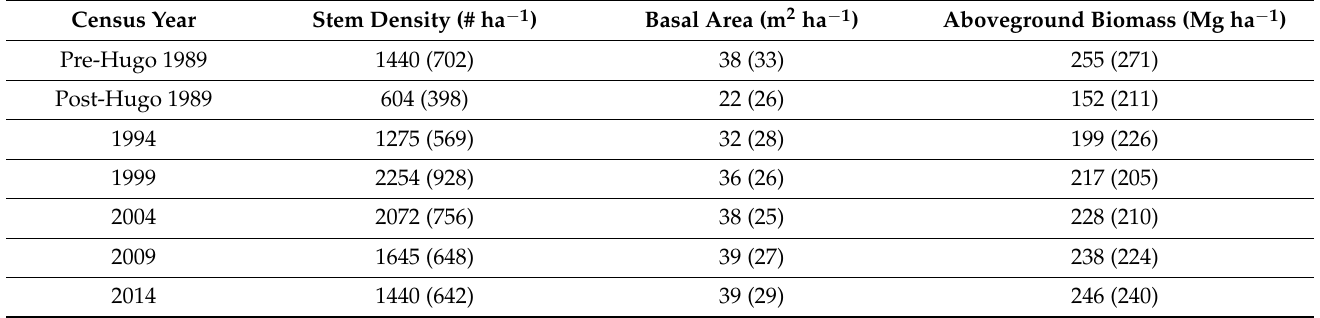
Table 2. Averages and standard deviations (in parentheses) of stem density, basal area, and above- ground biomass for the 85 continually censused plots in the Bisley Experimental